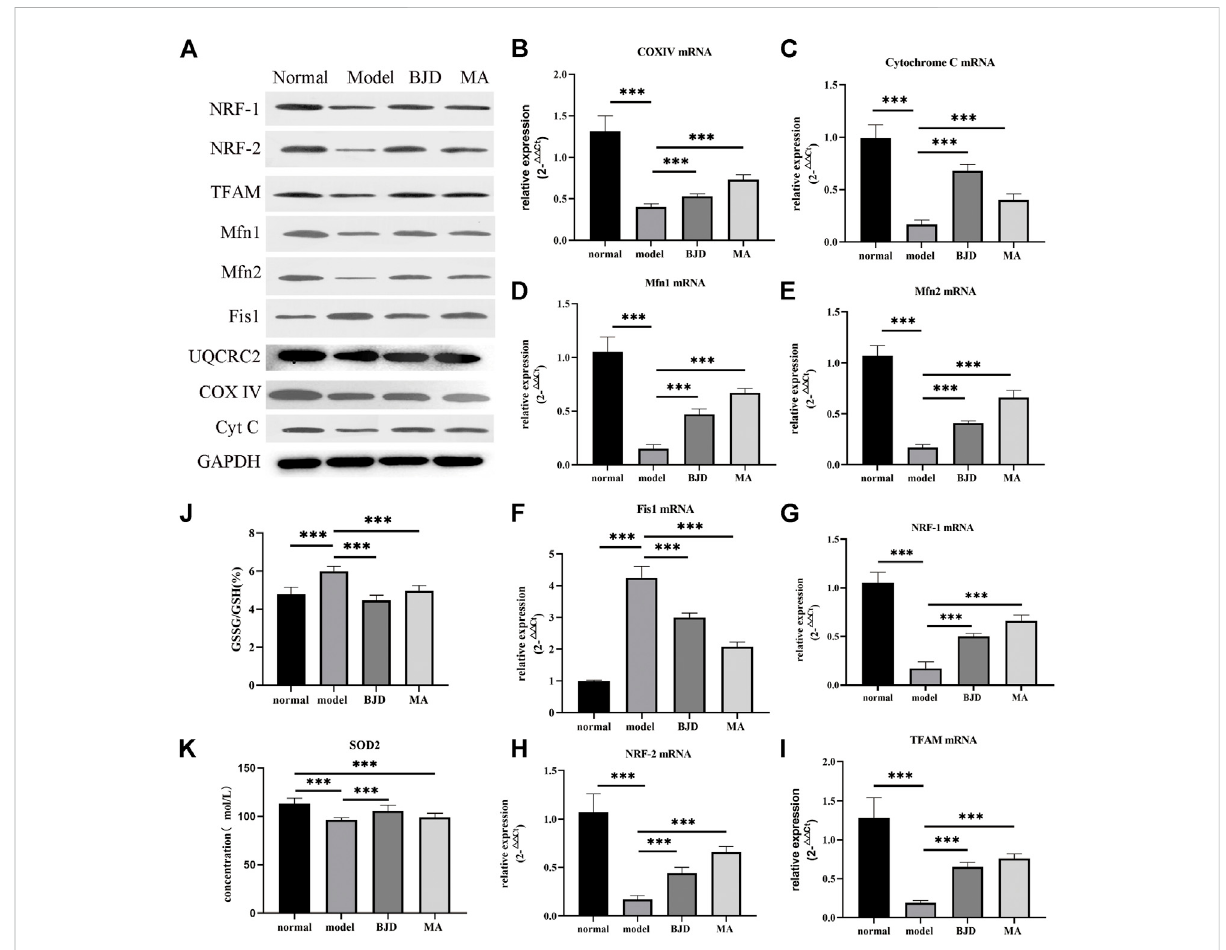
BJDregulatedmitochondrial functionin Apc Min/+ mice. (A) Therelativeexpressionsofproteinsrelatedtomitochondrialfunctionweredetected by western blotting in vivo , with GAPDH used as a loading control. (B – I) The relative expressions of genes related to mitochondrial function were detected by qPCR, with ß -actin used as an internal gene. (J,K) GSSG/GSH and SOD2 were detected by ELISA. The data are presented as the mean ± SD. *** p <